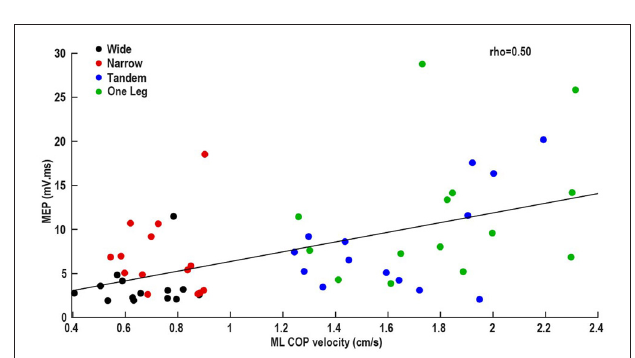
FIGURE 5 | Association between control i.e., wide stance ICF and difference in ICF between wide and narrow stance. Horizontal line represents no change in ICF, above line—increase in ICF with increasing task difficulty, below line—decrease in ICF with increasing task